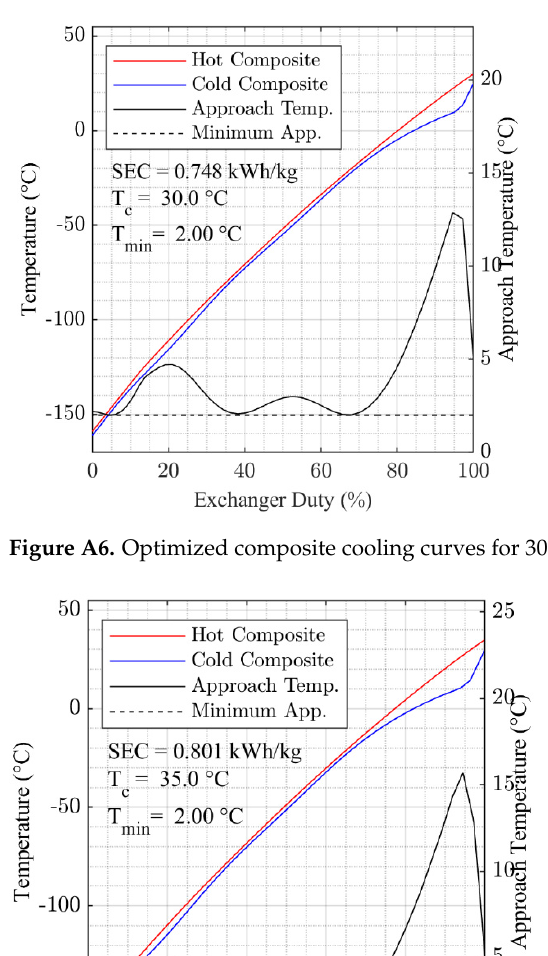
Energies 2021 , 14 , x FOR PEER REVIEW 18 of 19